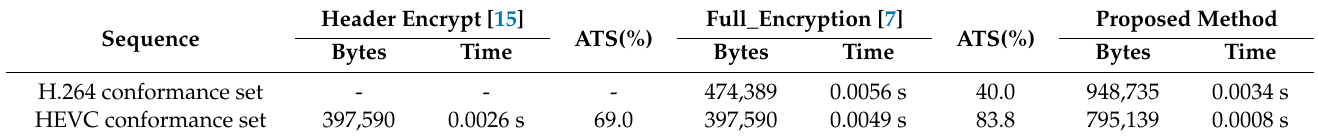
Table 4. Comparison of computational complexity with selective video syntax encryption methods.